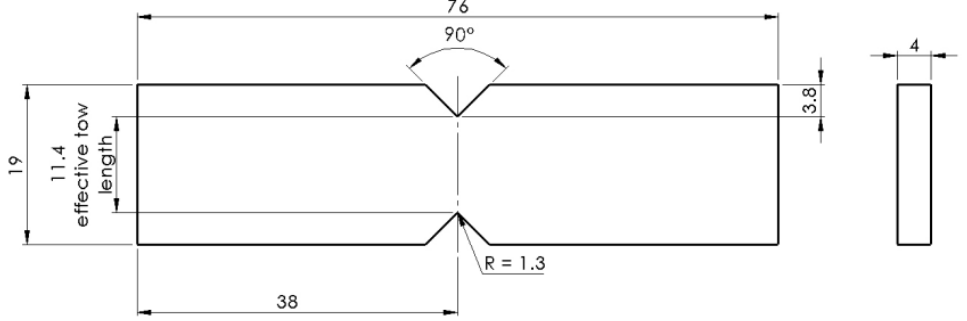
Figure 2. Fibers tensioned across silicon Iosipescu mould prior to resin injection.